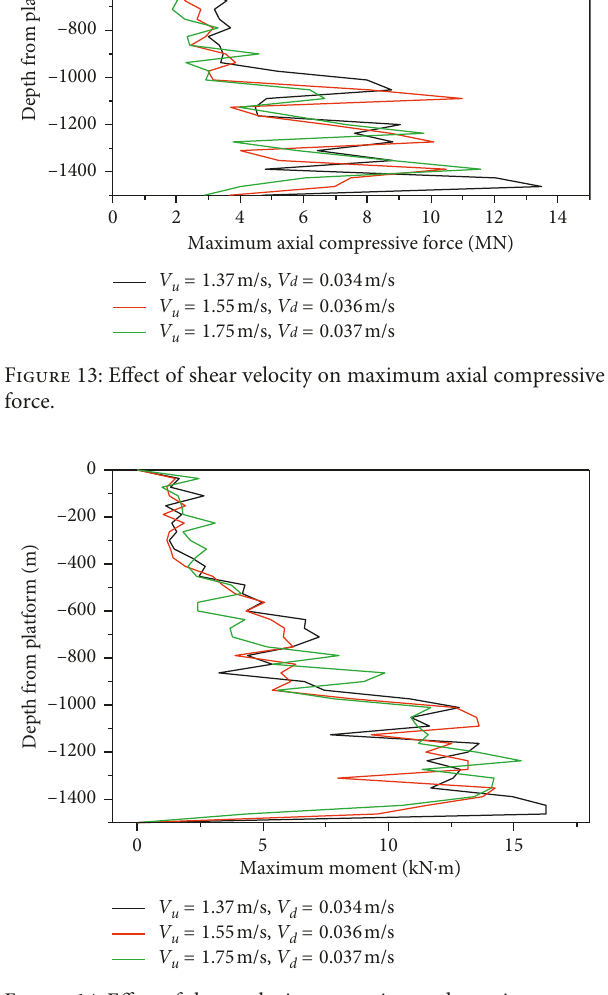
Figure 12: Effect of shear velocity on maximum axial tensile force.